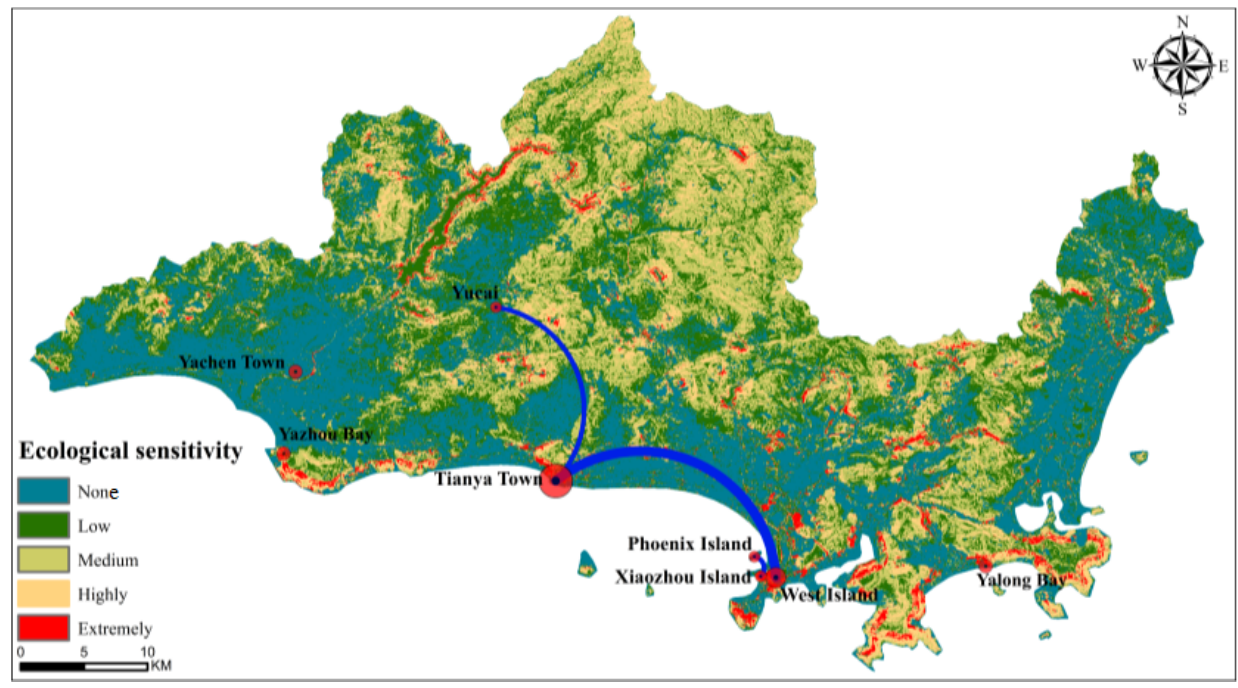
Figure 7. Important area mining based on multi-source data.